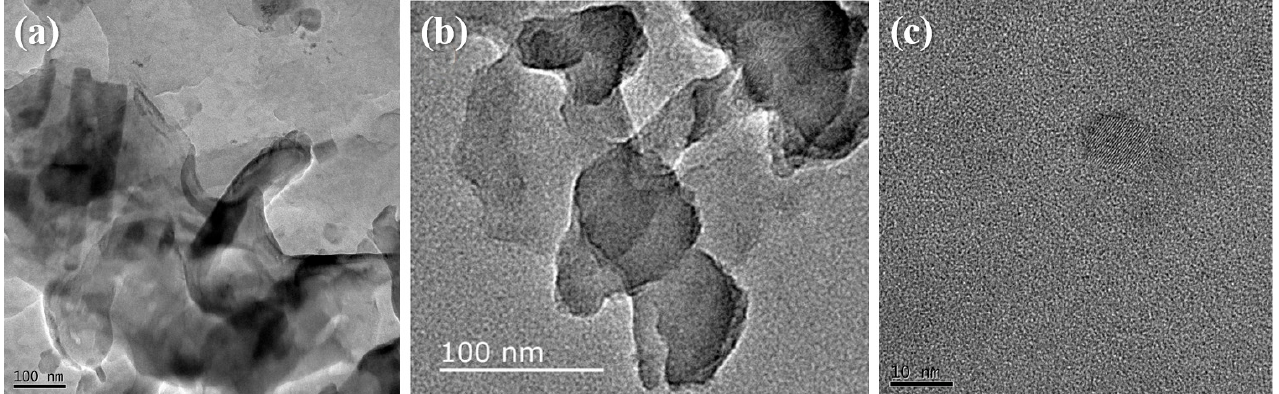
Figure 2. Comparison of transmission electron microscopy images of ( a ) F,O,S ‐ codoped g ‐ C 3 N 4 and ( b ) S ‐ doped g ‐ C 3 N 4 (reproduced from [15] under CC 4.0 license); ( c ) view of an agglomerate of